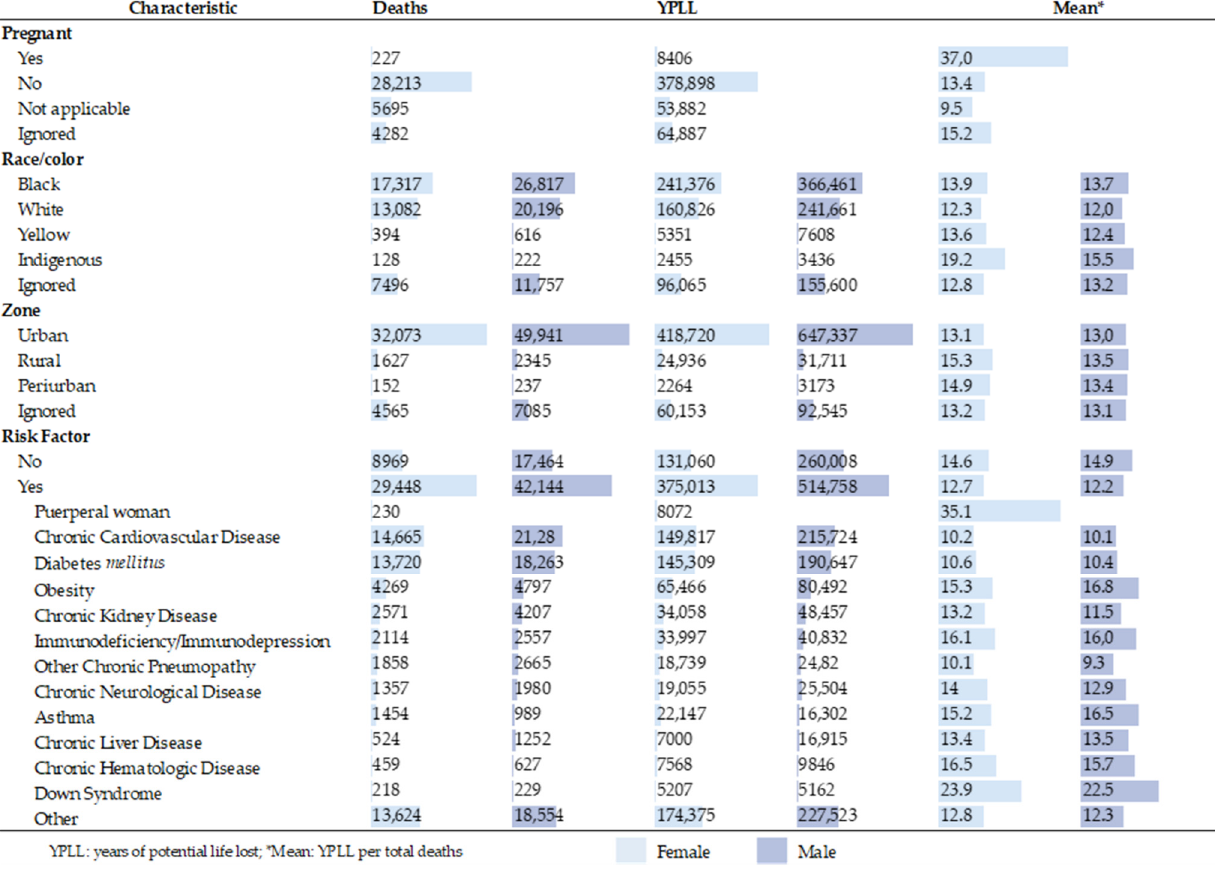
Figure 3. Fatalities and years of potential life lost in Brazil (2020) due to COVID-19, by gender, race/color, zone residence and risk factor.